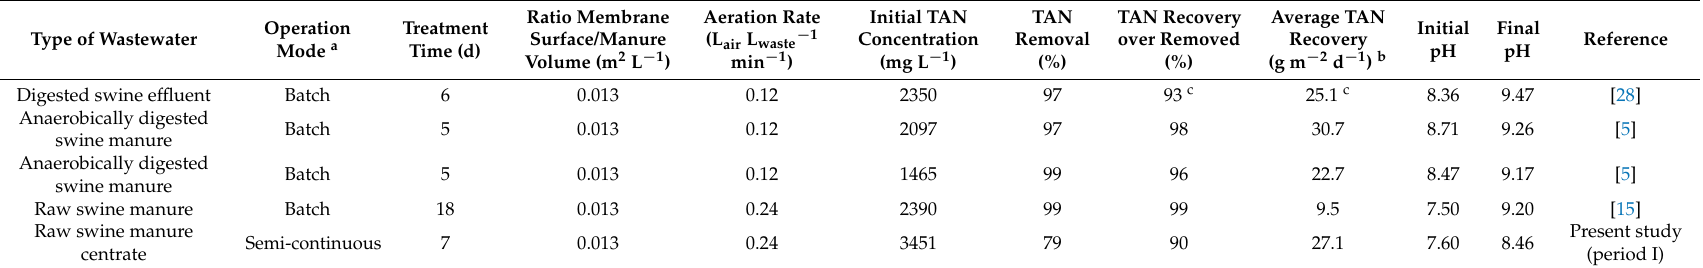
Table 3. Comparison of results from this study operating in semi-continuous mode with previous studies also recovering TAN using gas-permeable membranes from livestock wastewaters applying low-rate aeration but operating in batch